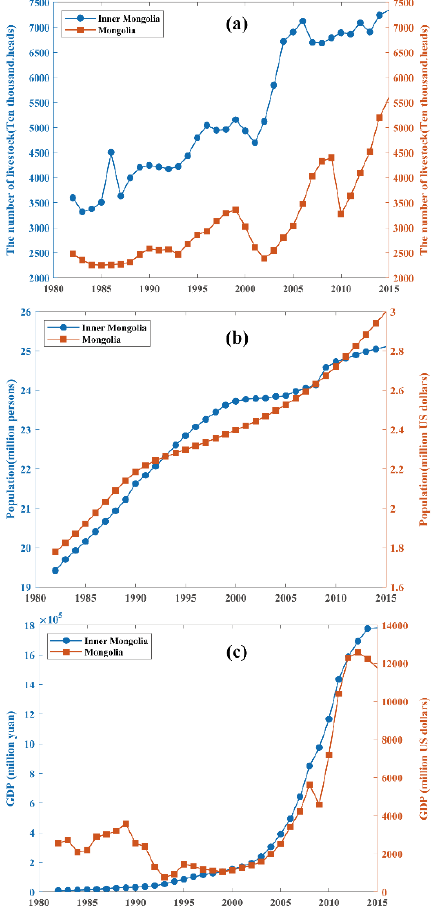
Figure 13. The linear trends in specific socioeconomic indicators for 1982–2015 in the Mongolian Plateau. ( a ) the numbers of livestock, ( b ) human population (Pop), ( c ) gross domestic product